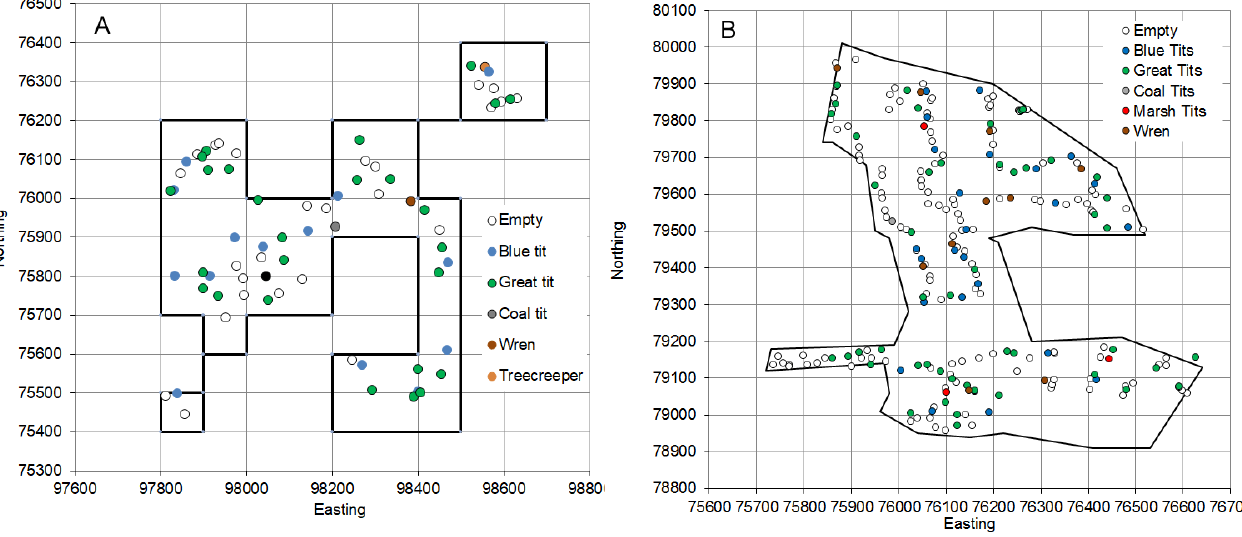
Fig. 1 . Plans based on UK Ordnance Survey grid system of Riseholme Park (A) and Treswell Wood (B) showing the distribution of the woodland (indicated by solid black line) at each site. Circles indicate position of nest boxes in 2014 and the species occupying